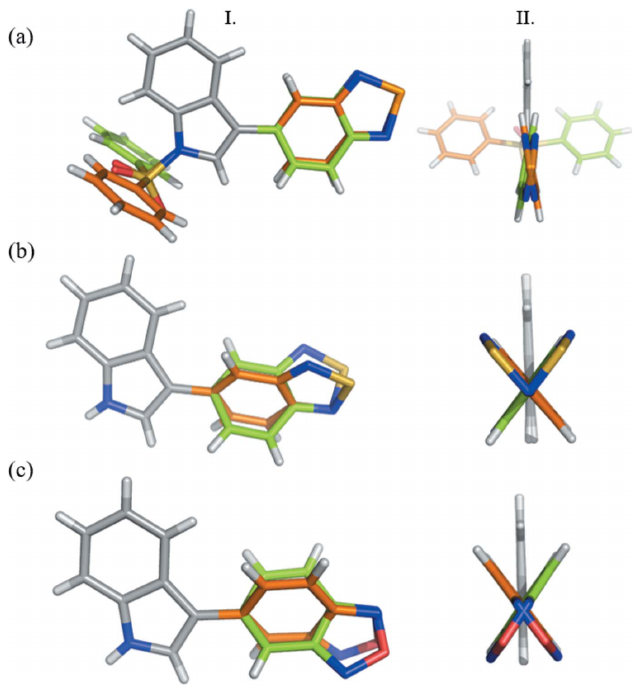
Figure 3 Two perpendicular views (I. and II.) of the two mirror images observed in the crystal packings for ( a ) p-bSe ( b ) bS and ( c ) bO. Superposition of the mirror images with respect to the indole group. Torsion angles are (cid:4) 168.3 (2) (cid:3) for p-bSe, (cid:4) 36.9 (2) (cid:3) for bS and (cid:4) 146.7 (2) (cid:3) for